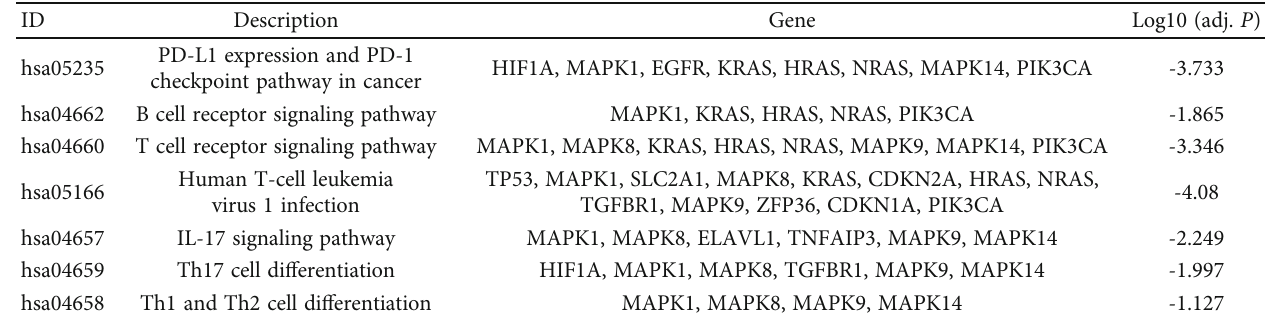
Table 1: Immune-related signaling pathways in the results of KEGG